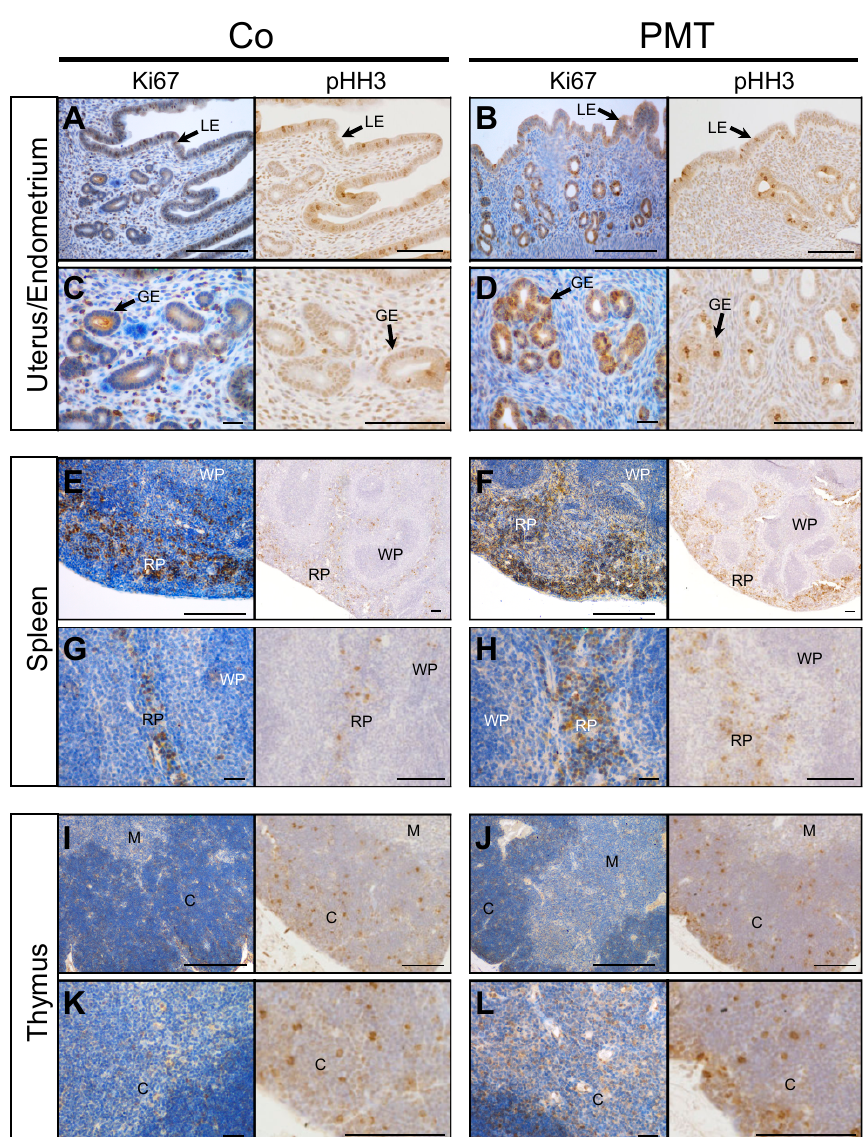
Figure 4. PMT stimulates proliferation markers in vivo. Immunohistochemical analysis of the cell cycle marker, Ki67, and mitosis marker, pHH3, in uterine ( A – D ), spleen ( E – H ) and thymus ( I – L ) tissues of animals treated with either PMT (3 ng) or vehicle control (Co) for one month. Micrographs represent 5 µ m para ffi n sections stained with specific antibodies against Ki67 or phospho-Histone H3 (pHH3) as described in the Methods. Uterus / endometrium: luminal epithelium (LE), glandular epithelium (GE); spleen: red pulp (RP), white pulp (WP); thymus: cortex (C), medulla (M). Scale bars: 100 μ m.